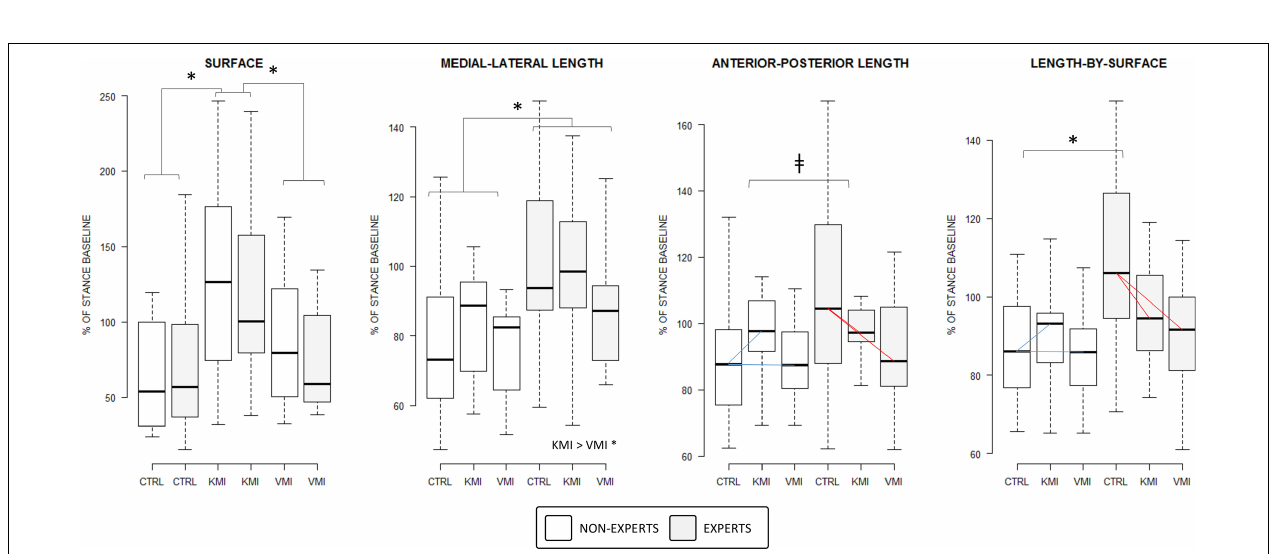
FIGURE 2 | Boxplot display of the main effect of GROUP on the variables recorded from stabilometric measures for the physical practice condition. Only the length of COP oscillations in the anterior-posterior axis differed between experts and non-experts. ∗ p < 0.05, NS: Not statistically significant.